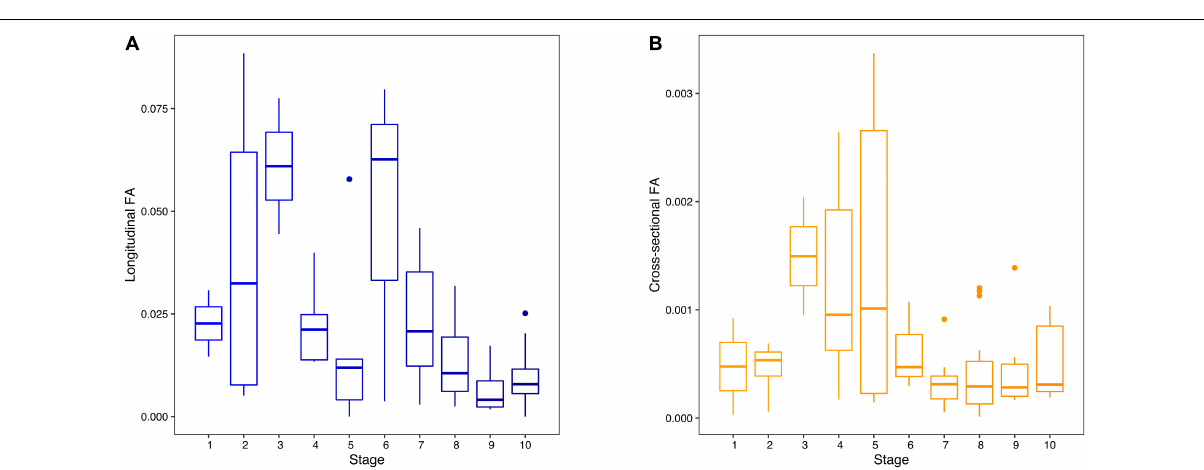
FIGURE 3 | Box plots of individual longitudinal (unsigned fluctuating asymmetry, FA) (A) and cross-sectional (unsigned FA) (B) FA values across development. Stages 1–10 represent early to late prenatal